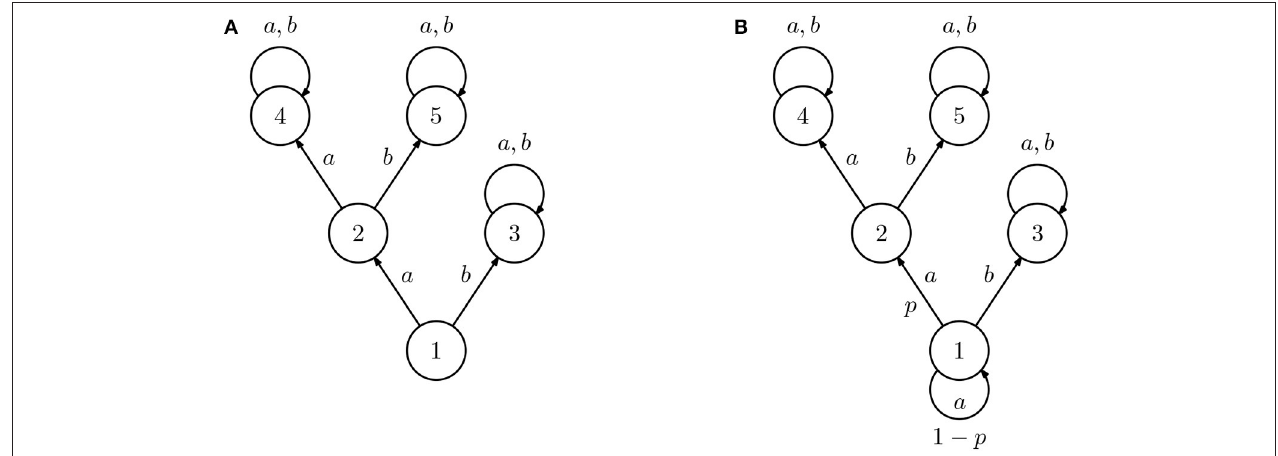
FIGURE 1 | Diagram representing two inverse reinforcement learning (IRL) agents (all unmarked transition are deterministic). The two agents are similar in all states except 1, where action a always succeeds for agent (A) but only succeeds with probability p for agent (B) .